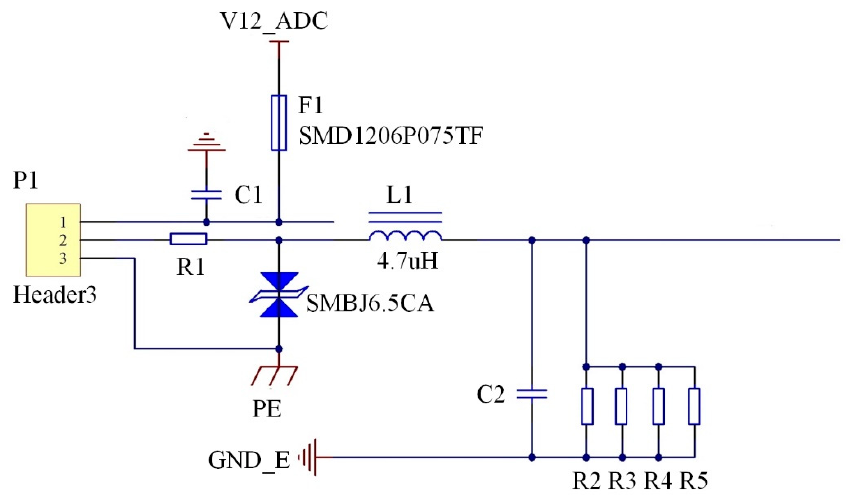
Figure 7. Circuit diagram of acquisition board.